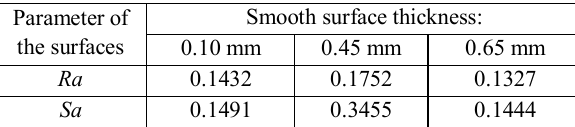
Table 1. M ain roughness parameters